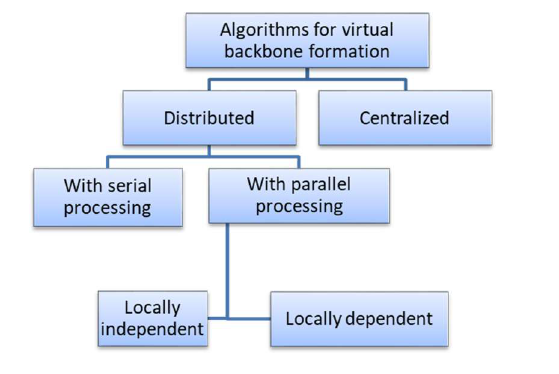
Figure 2. Classification of algorithms according to the method of information processing